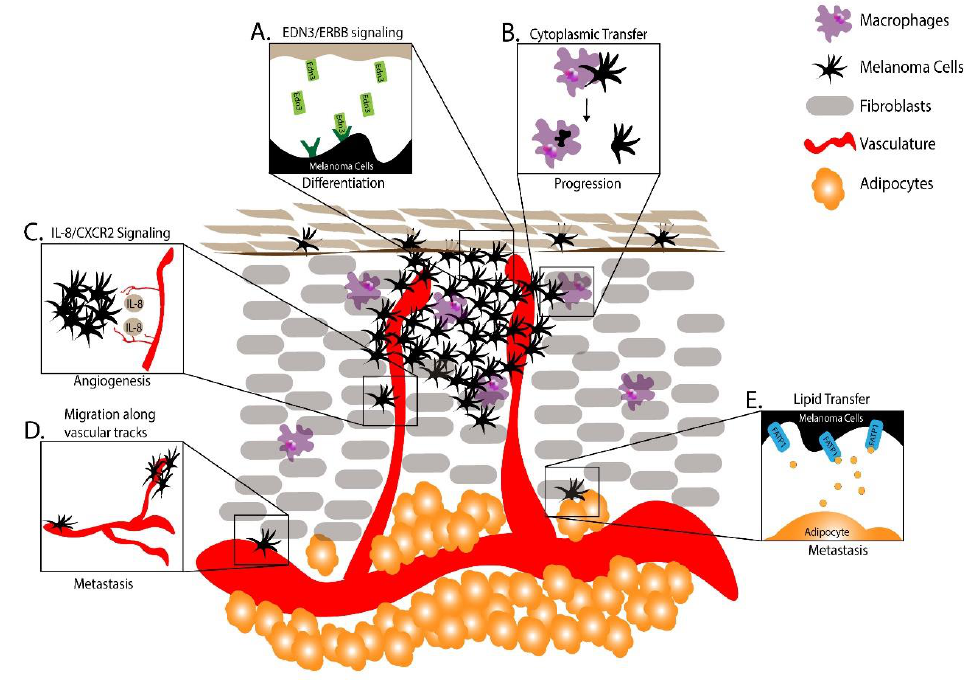
Figure 2. Microenvironmental factors governing melanoma progression from zebrafish. ( A ) Endothelin 3/erb-b2 receptor tyrosine kinase (EDN3/ERBB) signaling promoted differentiation and proliferation upon metastasis [97]. ( B ) Melanoma cell cytoplasmic transfer to macrophages promoted melanoma progression [99]. ( C ) Interleukin 8/C-X-C motif chemokine receptor 2 (IL-8/CXCR2) signaling encouraged melanoma progression [103,104]. ( D ) Melanoma cells cupped vasculature to melanoma progression [106]. 8. Future Directions While treatments for late-stage melanoma have greatly improved in the last decade, significant challenges remain in elucidating disease and drug resistance mechanisms and translating these findings to a clinical environment to benefit patients who respond poorly to current therapies. This group of poor responders is evidenced by the nearly 50% of metastatic melanoma patients who still die within five years of diagnosis [6,7]. Zebrafish models have provided, and can continue to provide, unique insights into pathogenesis and treatment. 8.1. Understanding the Micro- and Macro-Environmental Factors that Encourage Disease Initiation, Progression, Metastasis and Relapse Deeper knowledge of how the melanoma microenvironment influences disease progression will yield crucial understandings in how to target melanoma. The impacts of understanding these interactions are clinically important with recent advances in immunotherapy. The zebrafish has